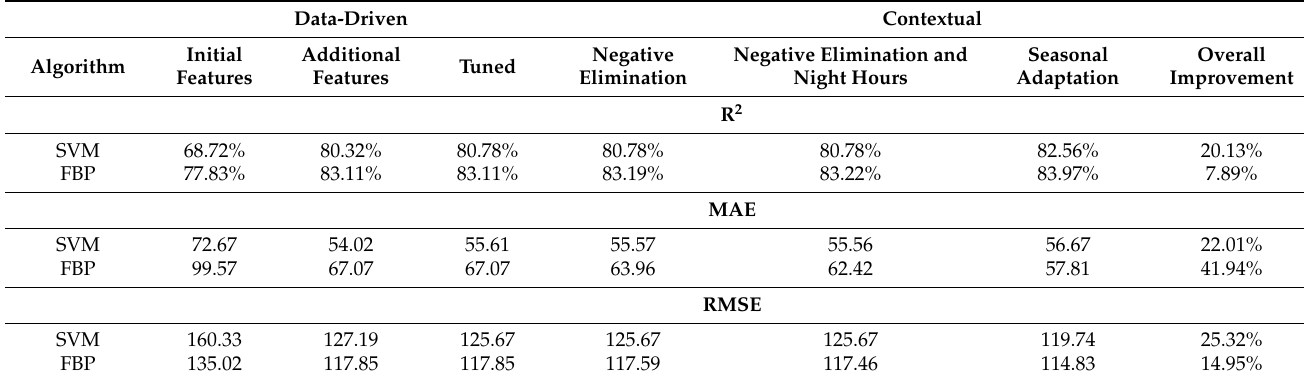
Table 5. Long-term results using data-driven and contextual optimisation.